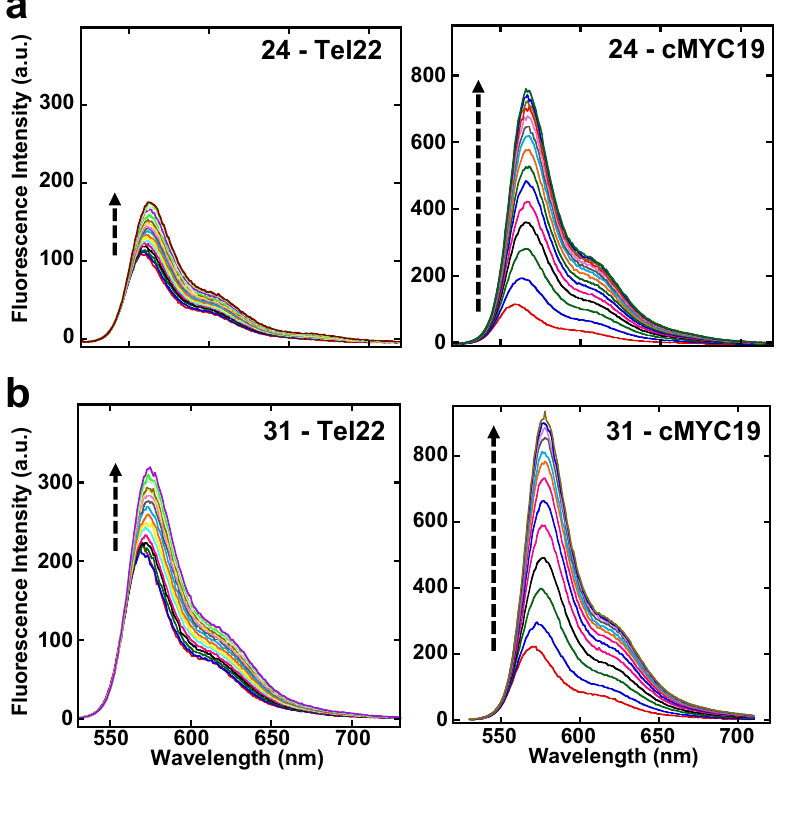
Figure 6. Fluorescence emission spectra of the parent cyanine ( 24 , panel a ) and the brominated analog ( 31 , panel b ) with Tel22 and cMYC19 quadruplex sequences. The arrow indicates increasing concentrations of DNA titrated into the ligand solution (1 µM) until no further change in the fluorescence emission signal was